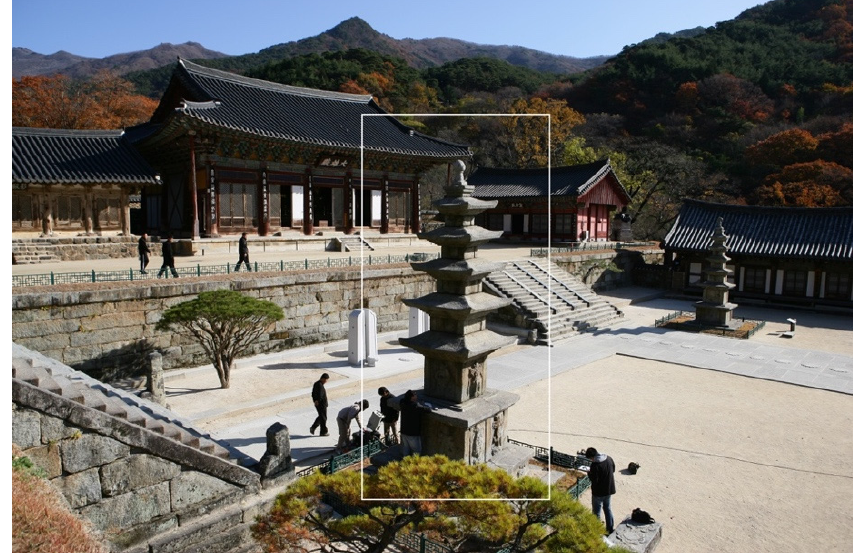
Figure 4. Two pagodas of Hwa ŏ m temple, Unified Silla, ninth century ( left ) western pagoda and ( right ) eastern pagoda [©Photograph by Lim, 2018].